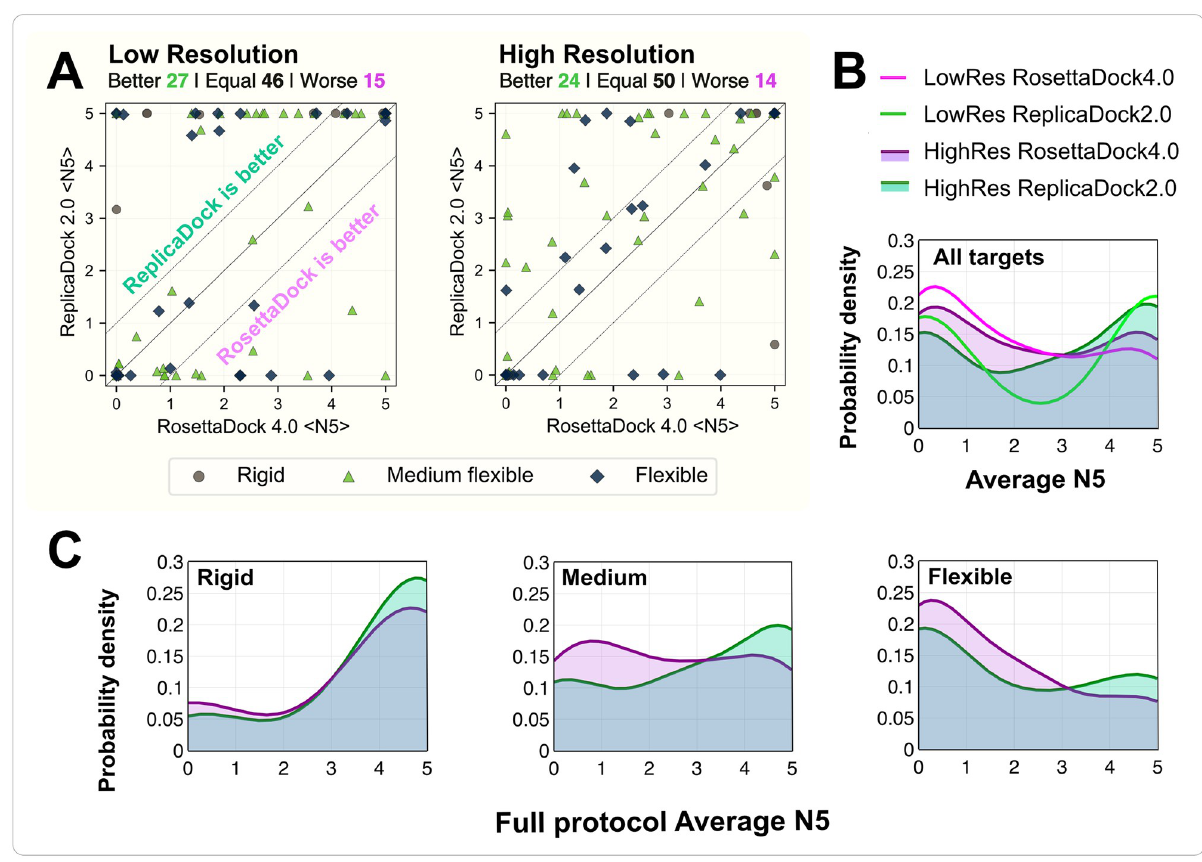
Fig 4. Comparison of performance metrics between RosettaDock 4.0 and ReplicaDock 2.0 for individual complexes in a benchmark set of 88 docking targets. (A) Comparison of h N5 i values after low-resolution and high-resolution stages (full protocol), respectively. Dashed lines highlight the region in which the two protocols differ significantly, i.e. by more than one point in their h N5 i values. Different symbols correspond to each target’s difficulty category (circle: rigid; triangle: medium; diamond: flexible). Points above the solid line represent better performance in ReplicaDock 2.0, while points below the line represent better performance in RosettaDock 4.0. After the full protocol, 24 targets are modeled significantly better and 14 complexes are modeled significantly worse. (B) Probability density curves versus h N5 i for all targets for ReplicaDock 2.0 (green) and RosettaDock 4.0 (purple). Low-resolution performance is indicated by lines (bright pink and bright green), and high-resolution performance is denoted by shaded area (purple and green). (C) Probability density curves versus full-protocol average N5 for rigid, medium and flexible targets